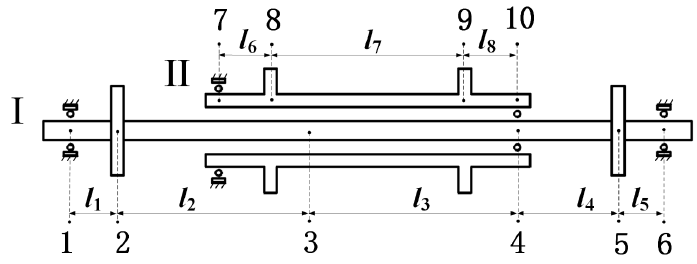
Figure 1. Structure diagram of the dual-rotor system. Table 1. The parameters of the dual-rotor system.